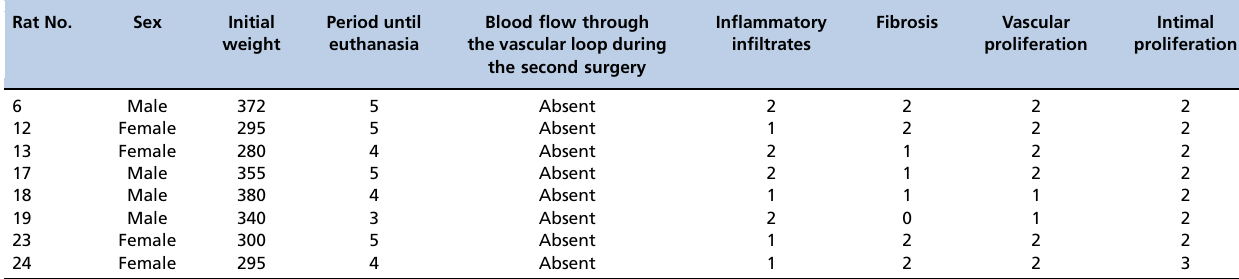
Table 2 - Histological evaluation of rats with occlusion of the vascular loop. Rat No.